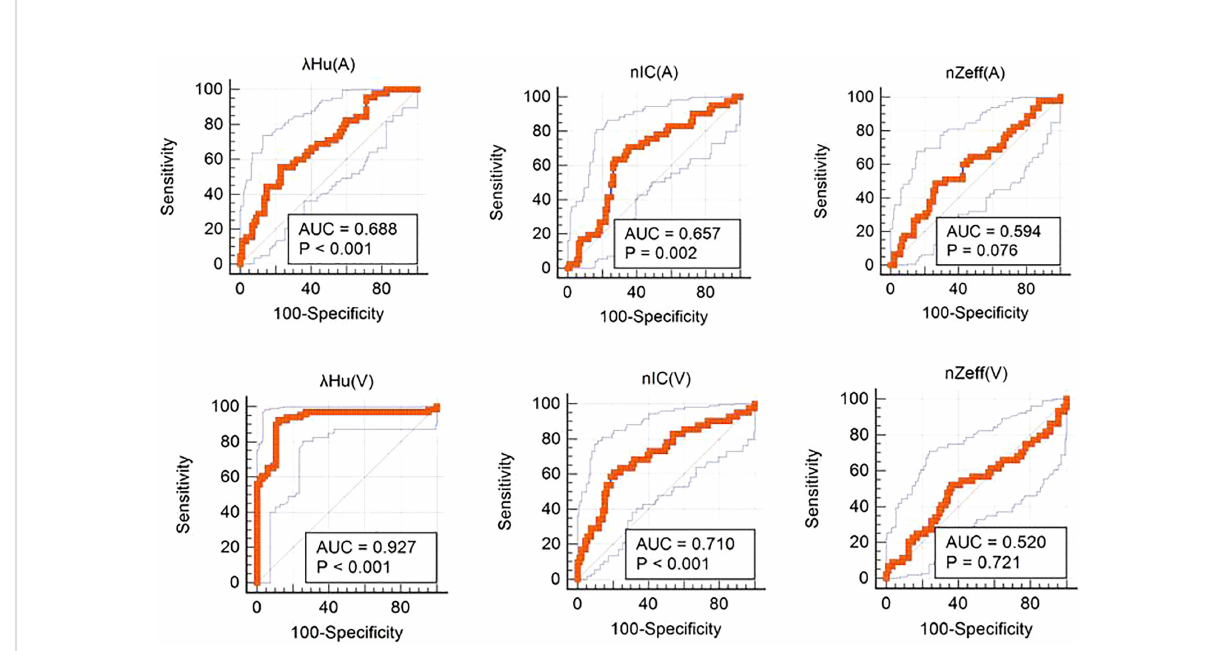
FIGURE 5 Receiver operating characteristic curves of quantitative dual-layer spectral computed tomography parameters for differentiating metastatic and nonmetastatic axillary lymph nodes. AUC, area under the